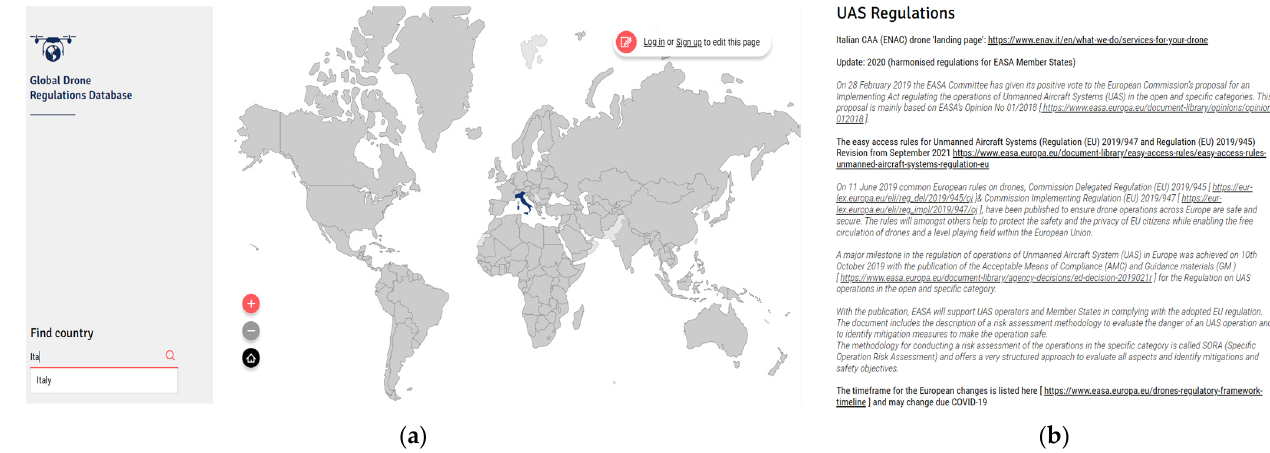
Figure 5. Global drone regulations database: choosing a country (colour blue), for example, Italy ( a ), consulting the regulations ( b ). consulting the regulations ( b